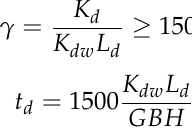
Figure 6. Variations in the distortional warping normal stress with the stiffness ratio.